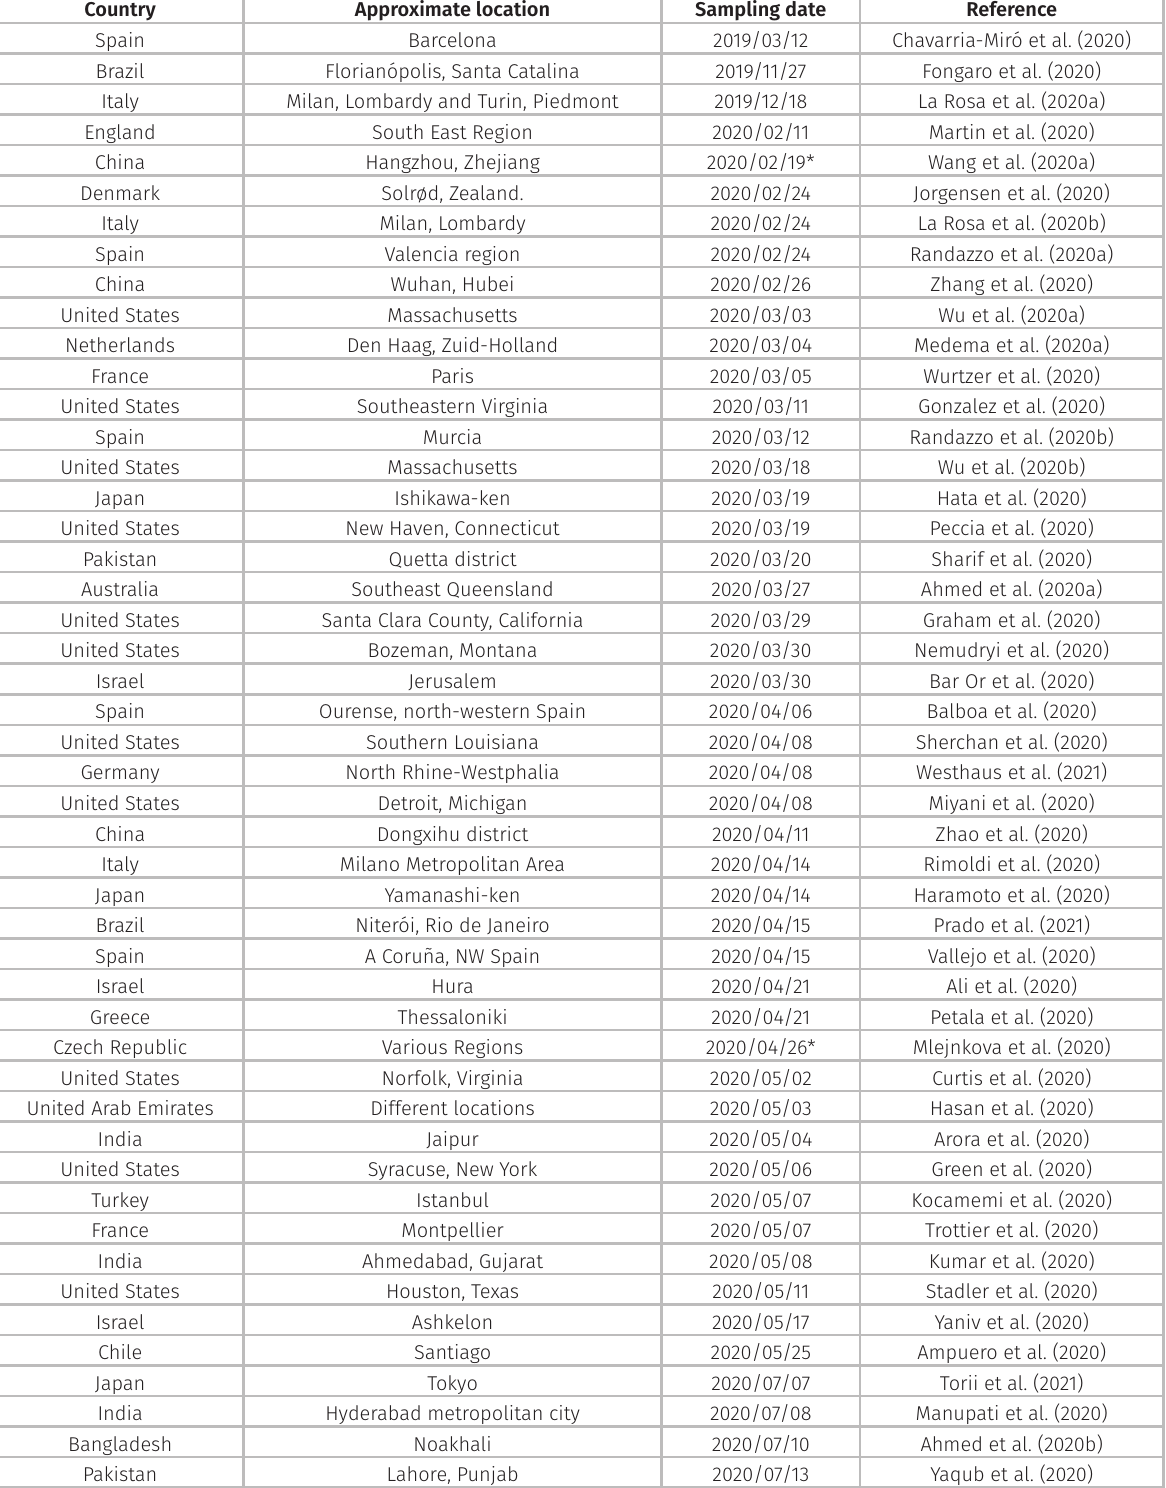
Table I. Reports of SARS-CoV-2 detection in wastewater and sludge.